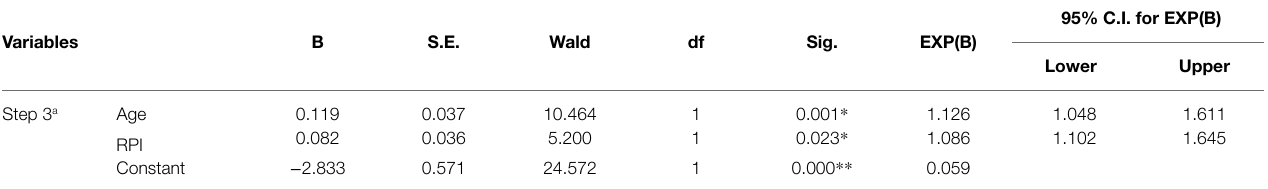
TABLE 6 | Variables in the equation (Features of emotional